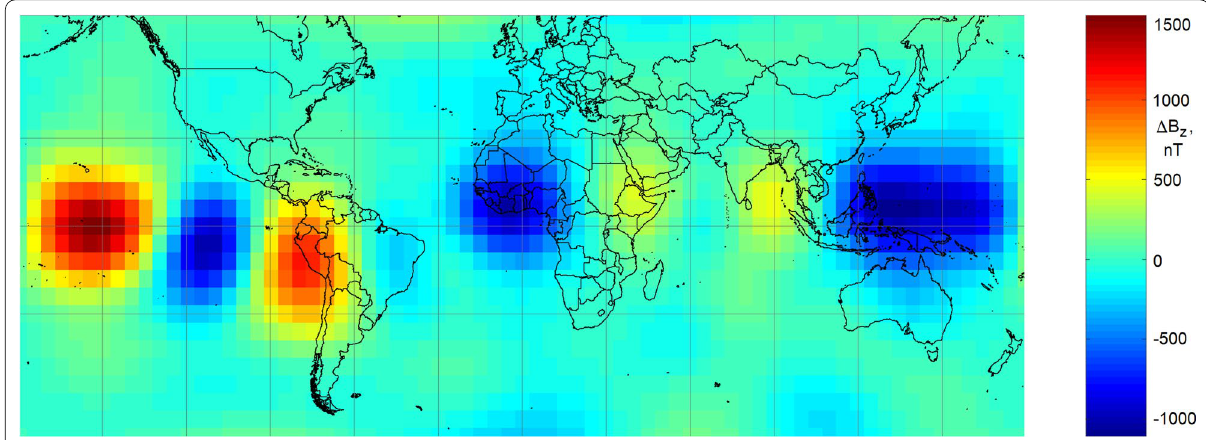
Fig. 4 Comparison of the model based on the Kosmos-49 data (M-1) with the IGRF model as a map of the Z component differences calculated at the nodes of the regular geographic grid at a spherical surface with the mean Earth radius, 6371.2